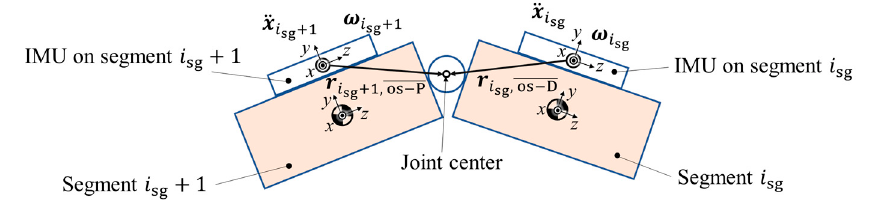
Figure 2. A schematic representation of two adjacent rigid segments connecetd via a